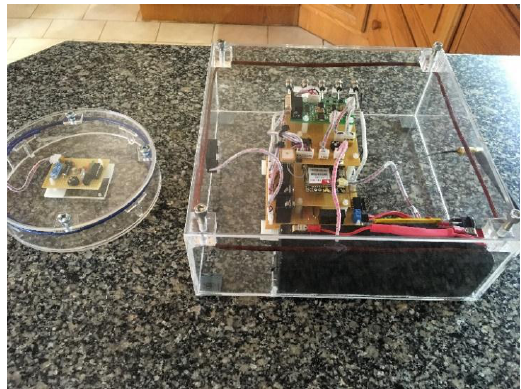
Figure 9. The main system and the RFID transponder with a circular antenna.